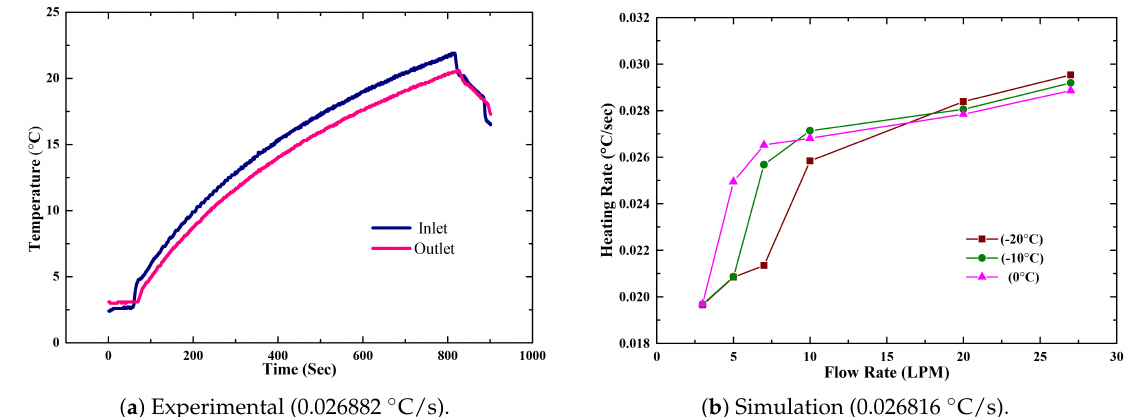
Figure 18. Comparison of battery heating rate experimental and simulation